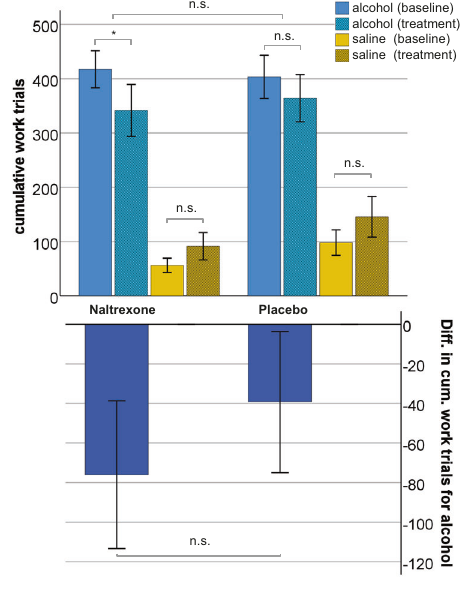
Fig. 2 Treatment outcomes. Cumulative work for alcohol and for saline before and during treatment in the ITT sample (upper panel) and primary study outcome (lower panel) * p < 0.05; *** p <